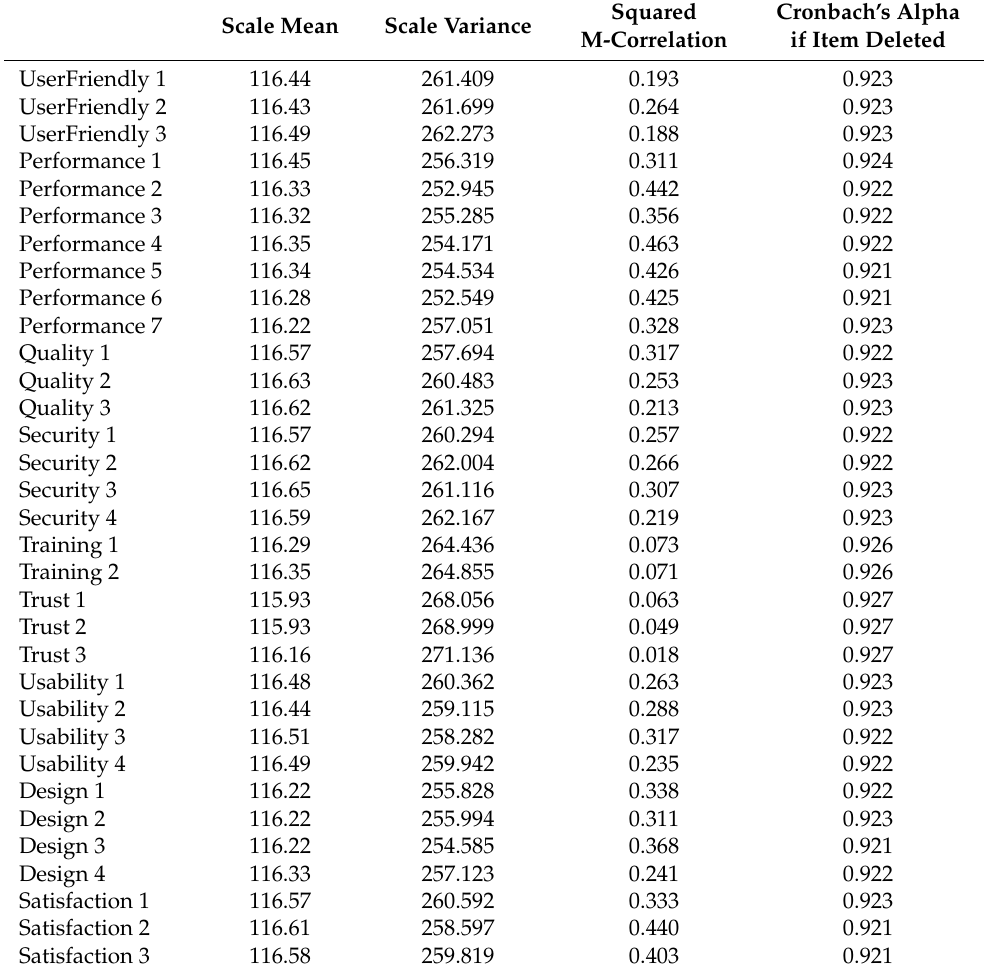
Table 1. Statistics for the final e-commerce satisfaction survey.